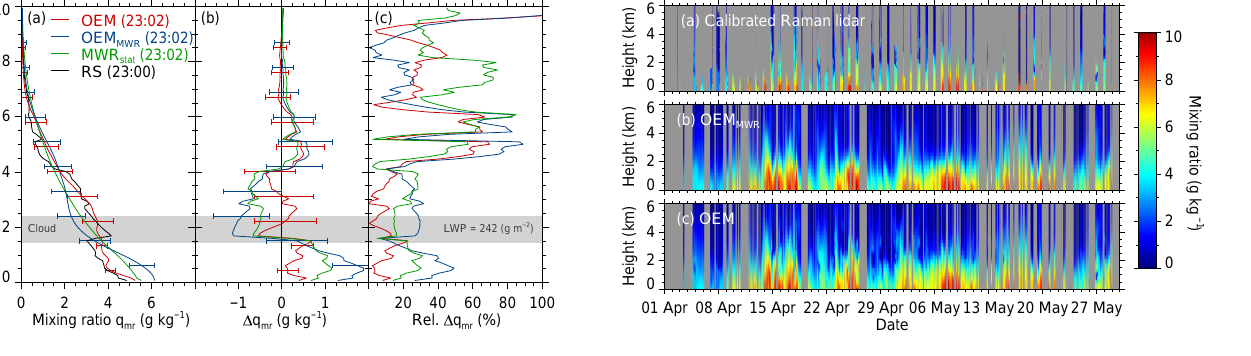
Figure 13. Three different height–time displays of mixing ratio pro- files during HOPE: (a) calibrated Raman lidar profiles, (b) optimal estimated profiles based only on MWR (and surface humidity) with- out any Raman lidar mixing ratio profile (OEM MWR ) and (c) opti- mal estimated profiles based on Kalman-filtered Raman lidar mix- ing ratio a priori profiles